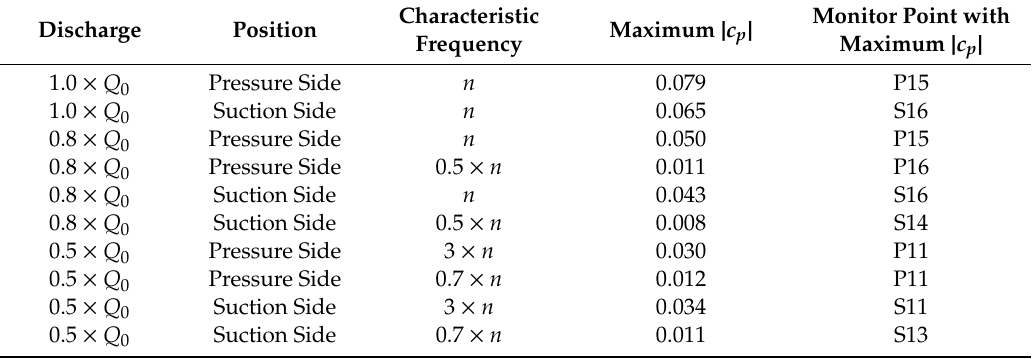
Table 3. Characteristic frequencies and amplitudes of pressure fluctuations at 1.0 × Q 0 , 0.8 × Q 0 , and